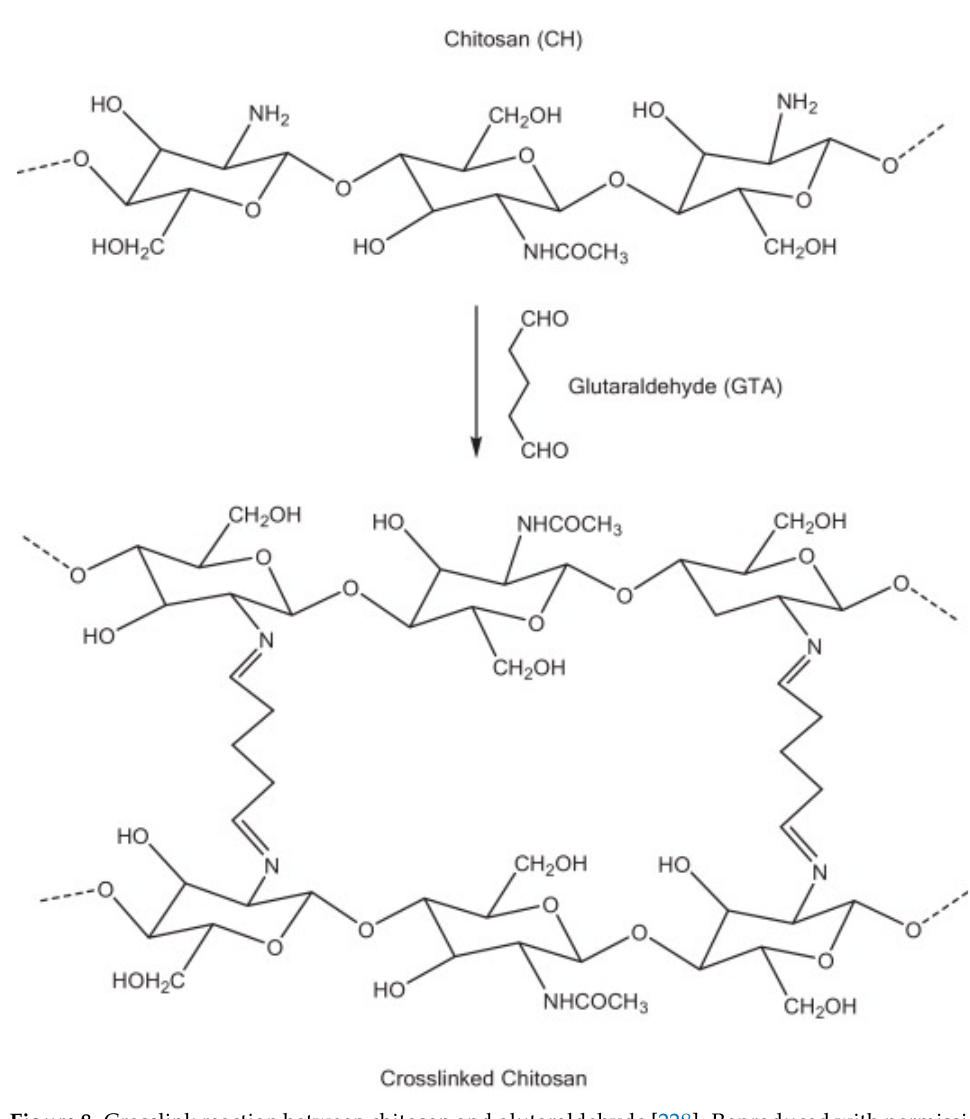
Figure 8. Crosslink reaction between chitosan and glutaraldehyde [228]. Reproduced with permission from Elsevier (Copyright © 2012).